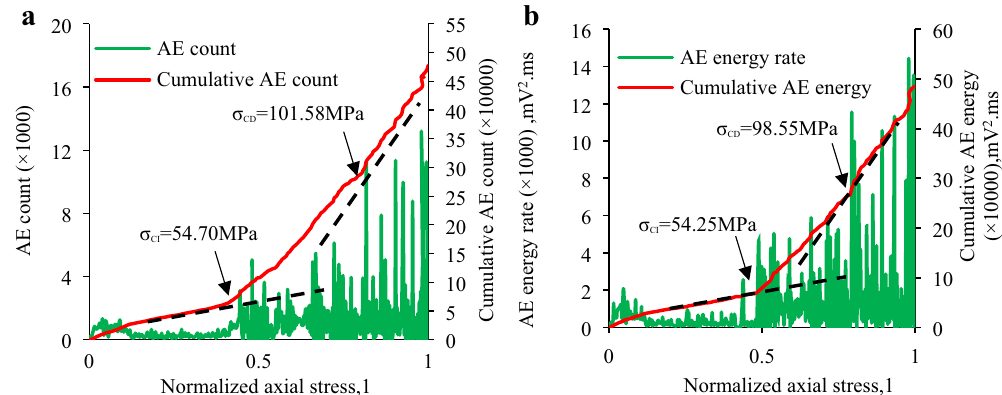
Figure 9. CI and CD thresholds of granite specimen in Test Case 1–1 ( θ = 0°) determined by AE energy and AE hits: ( a ) CI and CD thresholds determined by AE count; ( b ) CI and CD thresholds determined by AE energy.